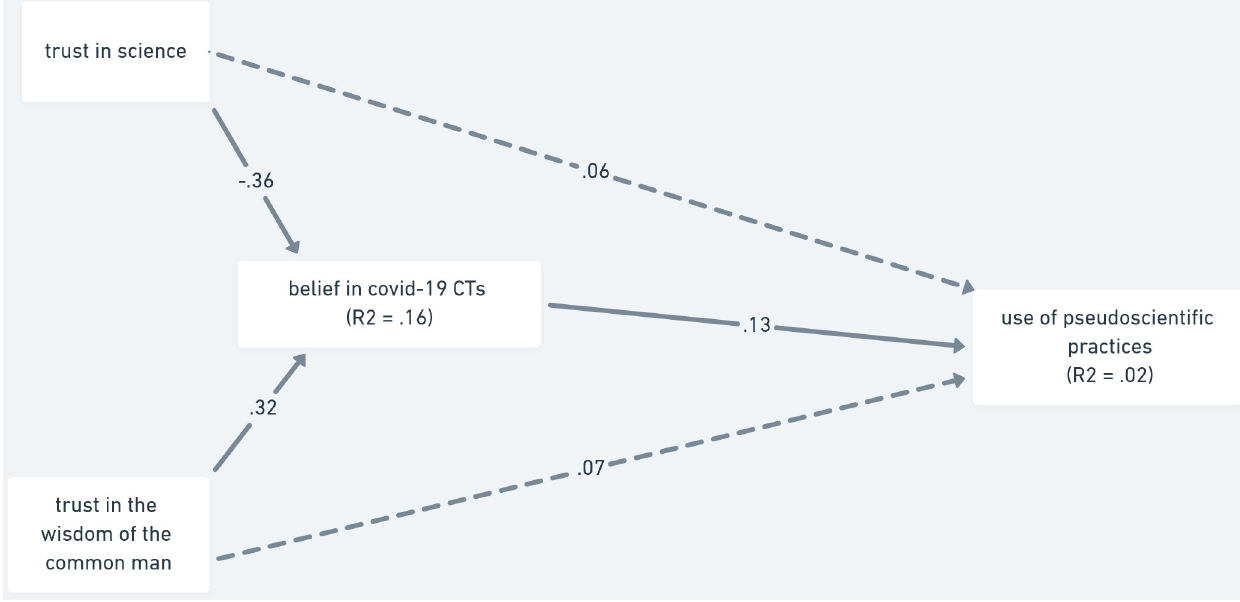
Fig 5. Mediation analysis of trust as a predictor of use of pseudoscientific practices via belief in COVID-19 conspiracy theories—Study 2. Note . The paths are shown with standardized estimates. Non-significant paths are shown as dashed lines.